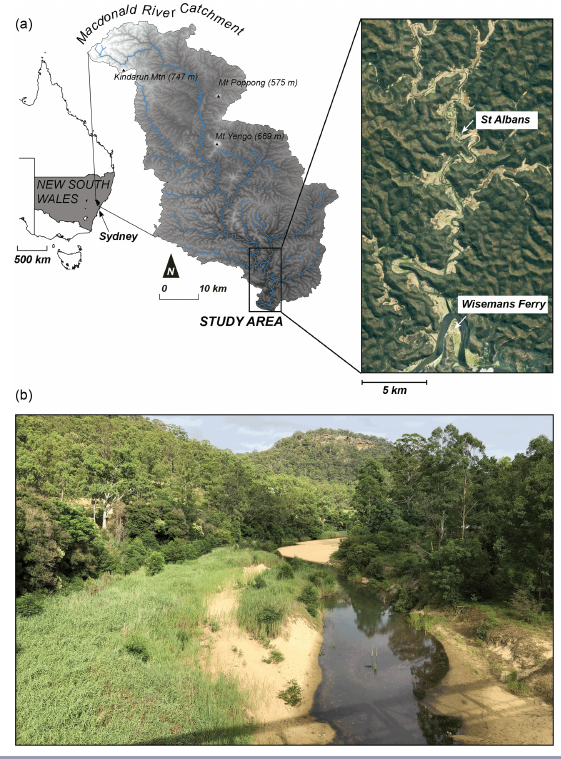
Albans, where majority of residents live. Satellite imagery sourced from Google Earth. (b) The Macdonald River looking upstream at town of St Albans. Note in-channel sand in form of sediment slug, which is an impact of historical flooding. Geomorphic recovery has since begun in the form of low-flow channel redefinition and bench building in-channel (see Mould and Fryirs